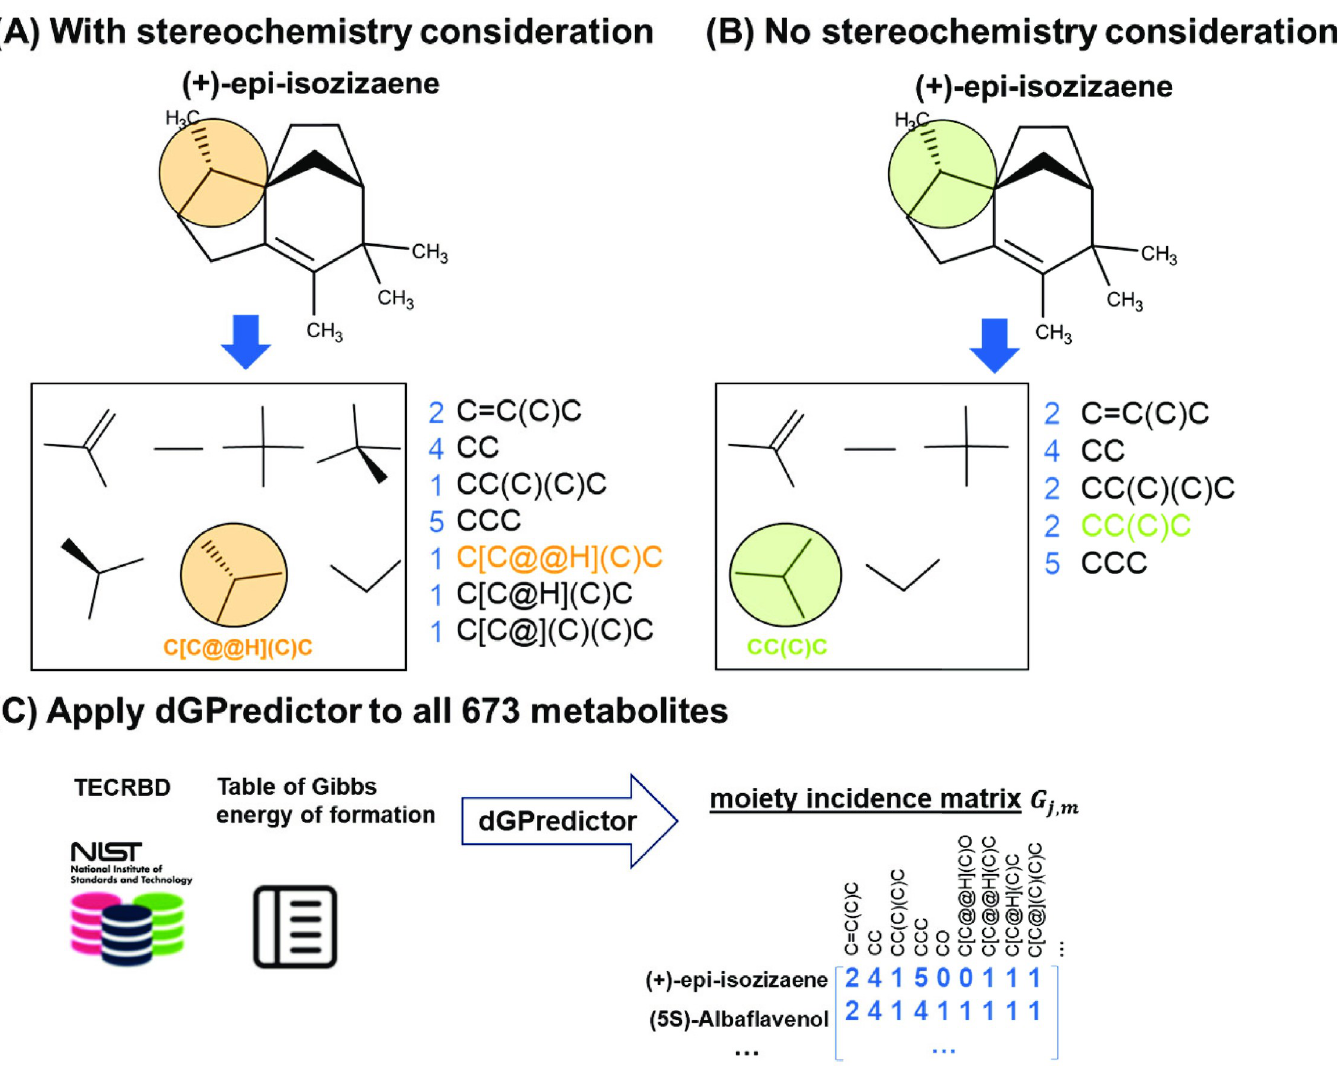
Fig 1. The substructures/chemical moieties generated by dGPredictor. The decomposition of (+)-epi-isozizaene (A) with stereochemistry consideration and (B) without stereochemistry consideration, and (C) moiety incidence matrix created by dGPredictor for all metabolites in TECRDB. Fig 1A and 1B highlight the possible loss of stereochemical information that may occur when not considering the two different configurations around an asymmetric tetrahedral atom, which results in the same moiety description for both configurations. We use (+)-epi- isozizaene as an example to demonstrate the chemical moieties-based metabolite descriptors used in dGPredictor. Fig 1A shows the seven chemical moieties generated from (+)-epi-isozi- zaene when stereochemistry is considered. The occurrence of the seven moieties is counted and used as the moiety incidence matrix G (shown in blue, where rows denote moieties, and i , g the columns count the occurrence of each moiety in the chemical structure and corresponding Simplified molecular-input line-entry system (SMILES) representation). The moiety shown in orange was obtained from the SMILES annotation C[C@@H](C)C, where the chiral specifica- tion (i.e., “C@@H”) indicates the carbon atom is the tetrahedral center. The two different sym- bols, “@” and “@@” indicate anticlockwise and clockwise configurations, respectively.